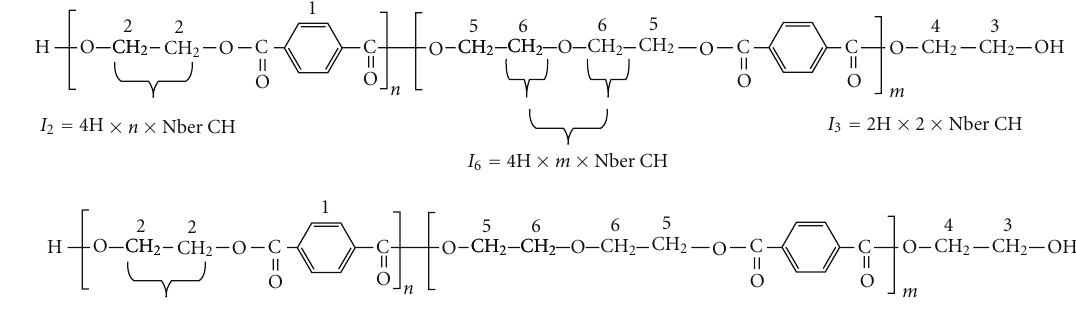
Figure 17: PET group intensities in macromolecular chain with hydroxyl termination.